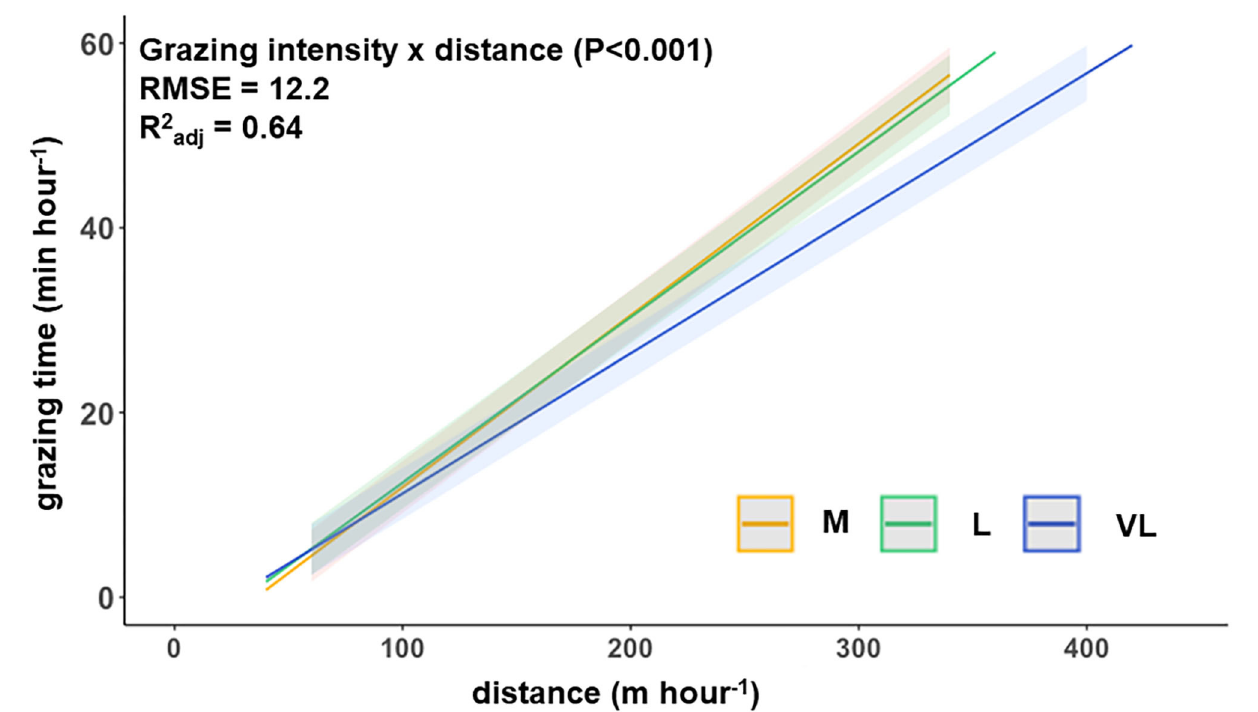
FIGURE 2 | Functional relationship between the hourly walking distance and grazing time per hour (spring 2019) for the three grazing intensities (model prediction). M, moderate; L, lenient; VL, very lenient in spring 2019.